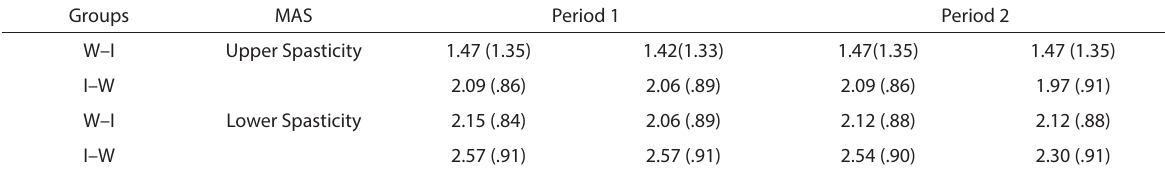
Table 5. Modified Ashworth Scale scores of the subjects - Mean